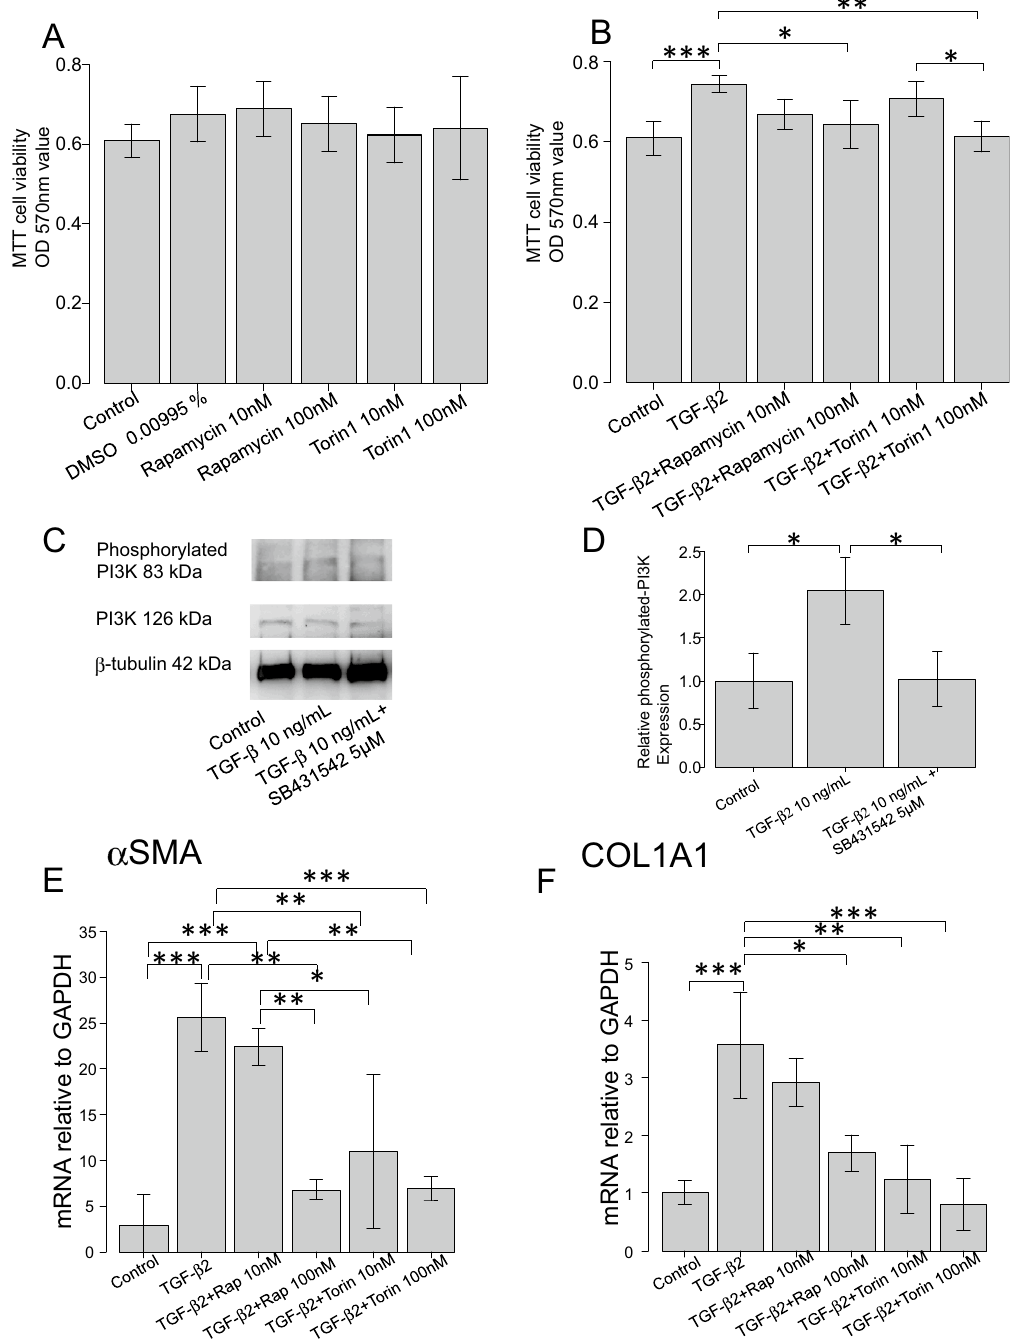
Figure 1. ( A ) and ( B ) Evaluation of the potential toxicities of compounds used in the hTM cells’ experiments and the effects of TGF-β2 and mTOR inhibitors on cell proliferation. ( A ) hTM cells’ toxicities after 24 h (n = 4). No compound was toxic. ( B ) Cell proliferation of hTM cells to 24 h (n = 4). Proliferation was significantly accelerated by TGF-β2 treatment (P < 0.001) and was suppressed by mTOR inhibitors (P < 0.05, P < 0.01). One- way analysis of variance followed by the Tukey post-hoc test. *P < 0.05, **P < 0.01, and ***P < 0.001. ( C ) and ( D ) Upregulation of the hTM cells’ PI3K-mTOR pathway by TGF-β2. ( C ) The expression level of phosphorylated- PI3K on treatment with 10 ng/mL of TGF-β2 with or without TGF-β inhibitor (5 μM SB431542) (n = 3). The results are expressed relative to that of the loading control (β-tubulin). TGF-β2 upregulated phosphorylated- PI3K in hTM cells, and the change was attenuated with TGF-β inhibitor (5 μM SB431542). One-way analysis of variance followed by the Tukey post-hoc test. *P < 0.05. ( E ) and ( F ) qPCR quantification of the mRNAs encoding αSMA and COL1A1 in hTM cells relative to the GAPDH level (n = 4). The relative mRNA expression levels of ( A ) αSMA and ( B ) COL1A1 were significantly higher (compared to the control values) on stimulation with TGF-β2, and the increases were reduced by the mTOR inhibitors rapamycin and Torin 1. One-way analysis of variance followed by the Tukey post-hoc test. *P < 0.05, **P < 0.01, ***P <